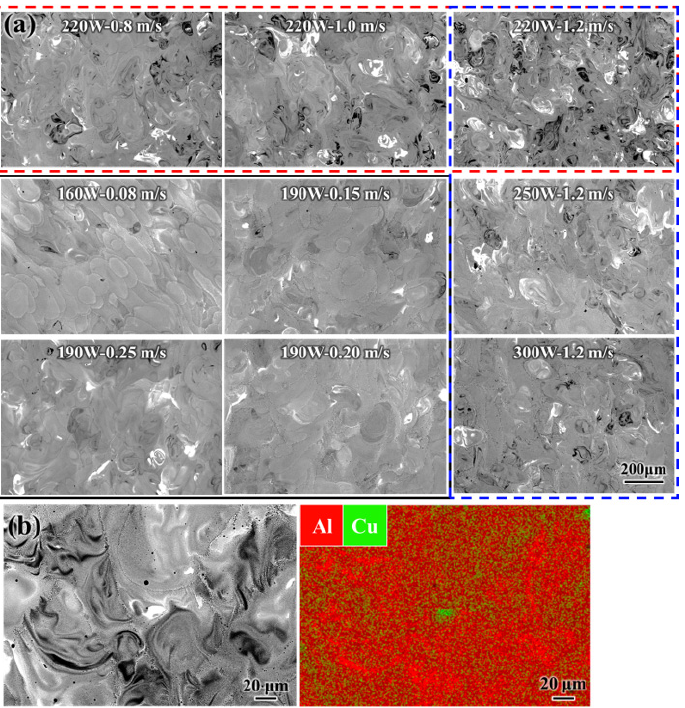
Figure 3. Composition inhomogeneity within the Al-20Cu samples printed at various scanning rates and laser powers: ( a ) BSE micrographs of all samples, and ( b ) EDS mapping analysis of composition inhomogeneity region within the sample processed by laser power of 220 W and scanning rate of 1.2 m/s.